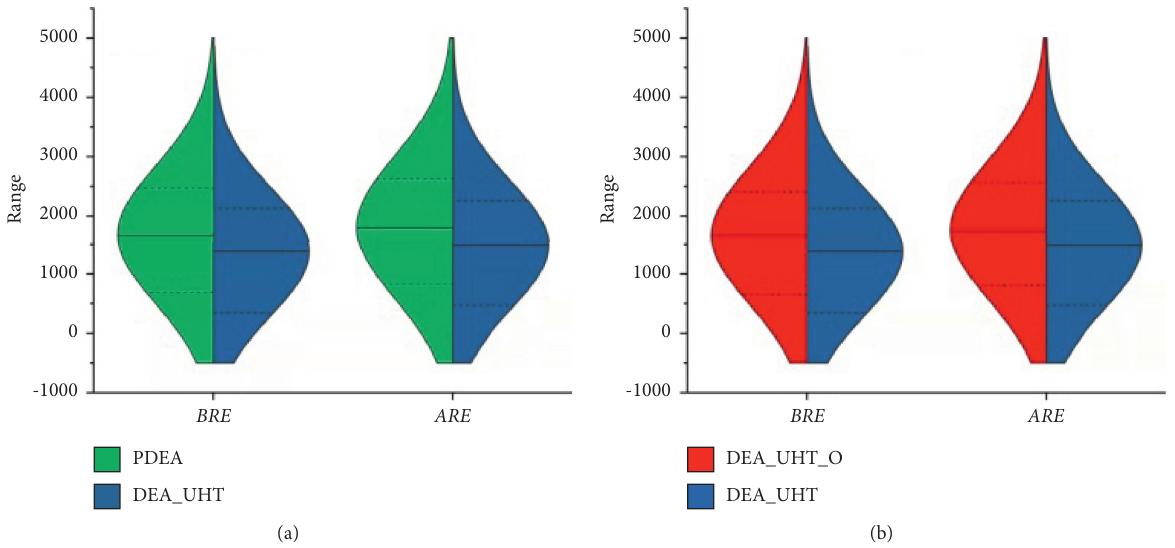
Figure 2: Violin plots for comparison results in Table 2. (a) PDEA vs DEA_UHT. (b) DEA_UHT_O vs DEA_UHT.